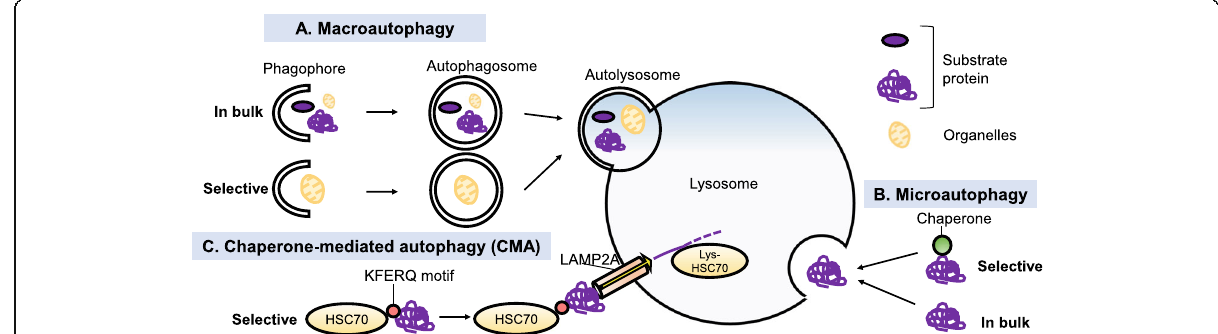
Fig. 1 Three forms of autophagy. Cellular components can be delivered into lysosomes for degradation through three distinct autophagic pathways. A During the process of macroautophagy, substrate proteins and organelles are sequestered by autophagosome. Fusion of a lysosome with the autophagosome to form the autolysosome is crucial process for degradation. B During microautophagy, small components of the cytoplasm are engulfed by direct invagination into lysosomes. C CMA degrades soluble proteins containing KFERQ-like motif, which are specifically recognized by chaperone HSC70 and co-chaperones. Lysosome-associated membrane protein type 2A (LAMP2A) is responsible for substrate binding and internalization to